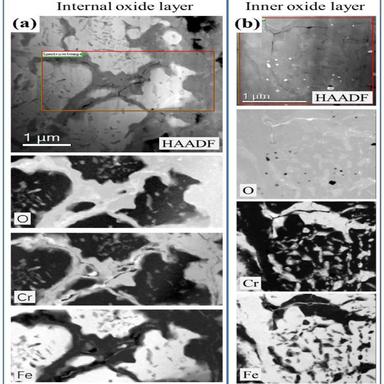
EELS analysis results (a) in the internal oxide layer, (b) in the inner oxide layer at the internal-inner oxide layer interface of T91 after exposure in SCW at 600 °C for 1500 h.